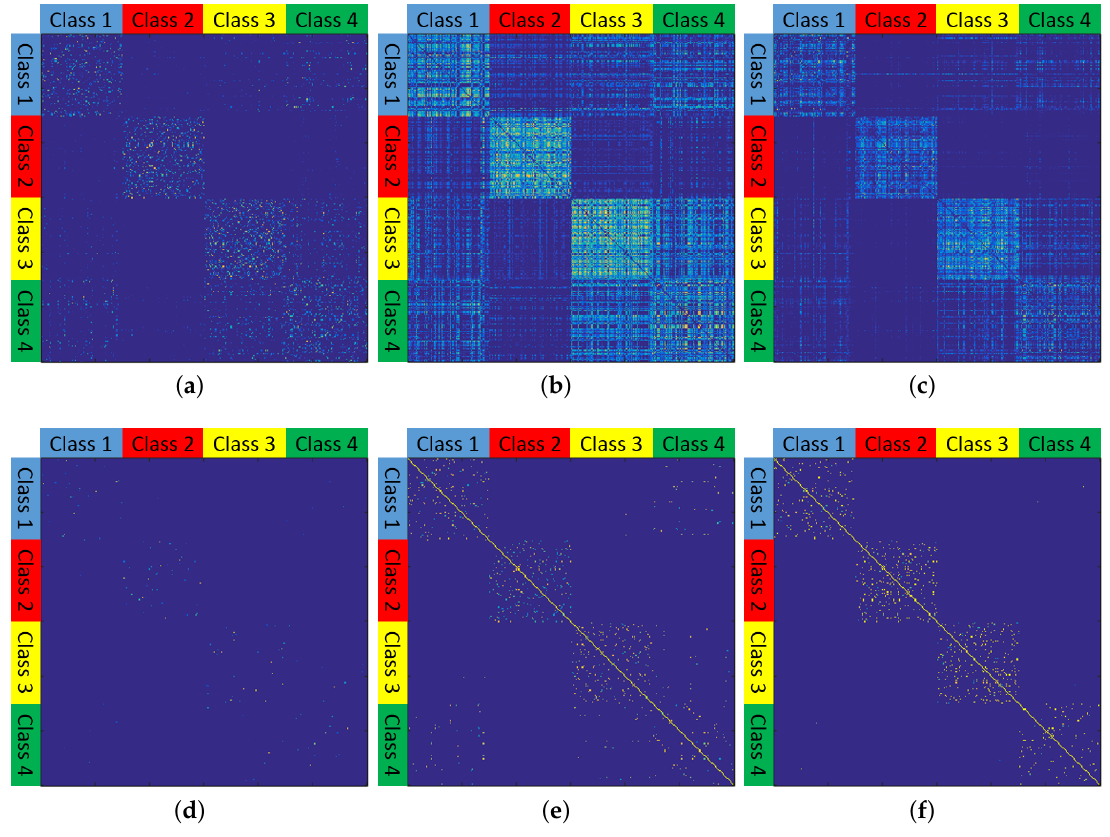
Figure 4. Similarity matrix obtained by ( a ) SSC, ( b ) L2-SSC, ( c ) JSSC, ( d ) SSC-OMP, ( e ) Sketch-SSC and ( f )